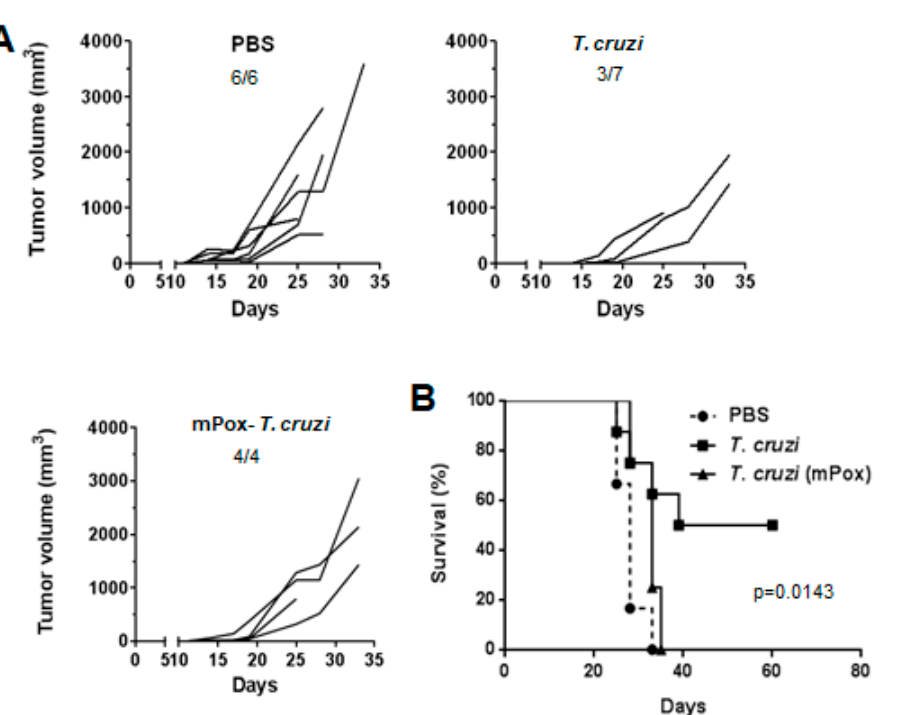
Figure 6. Glycoconjugates in T. cruzi lysate mediate tumour protection: ( A ) C57BL/6 mice (n = 4–7) were pre-treated three times in two-week intervals with T. cruzi (300 µ g/mouse), m-periodate oxidised T. cruzi (mPox- T. cruzi, 300 µ g/mouse) or PBS in alum before LL/2 cells challenge (100,000 cells/mouse). Tumour growth was measured regularly using a calliper. Numbers rep- resent the number of mice that developed tumours out of the total mouse number used in the experiment. ( B ) Survival of treated and control mice was followed for 80 days after tumour challenge. Representative results from two independent experiments are